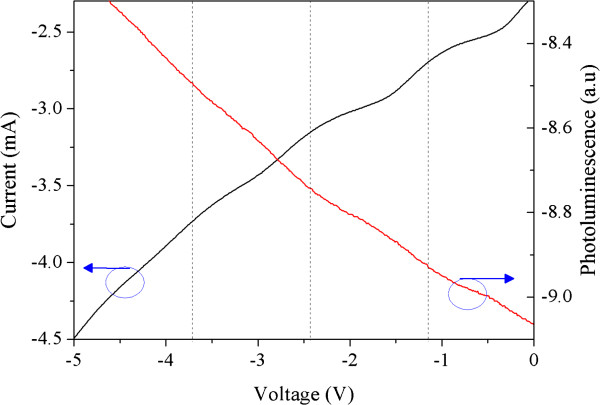
PC and PLb for p-i-n GaInNAs MQWs at T = 100 K.